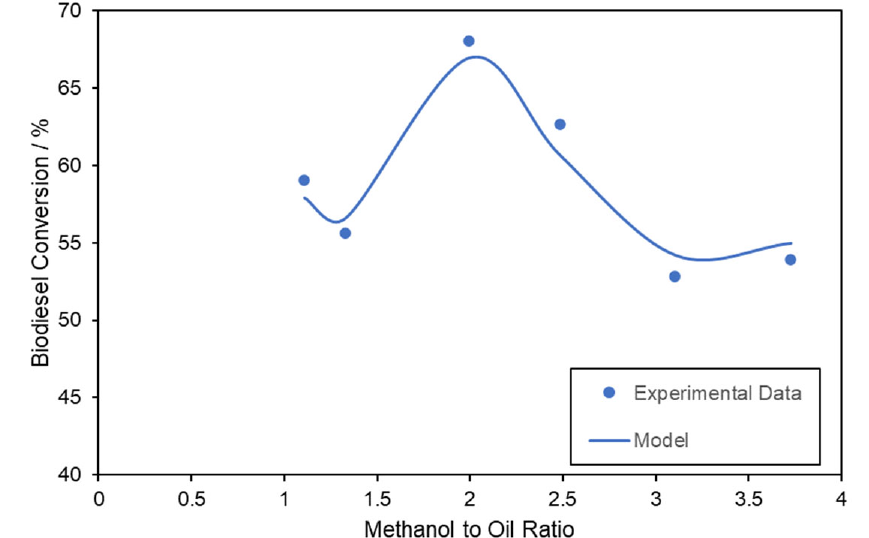
Figure 8. Methanol-to-oil ratio effect at a constant temperature of 303 K and reaction time of 420 min, using oil derived from Chlorella protothecoides . Experimental data were taken from [34].